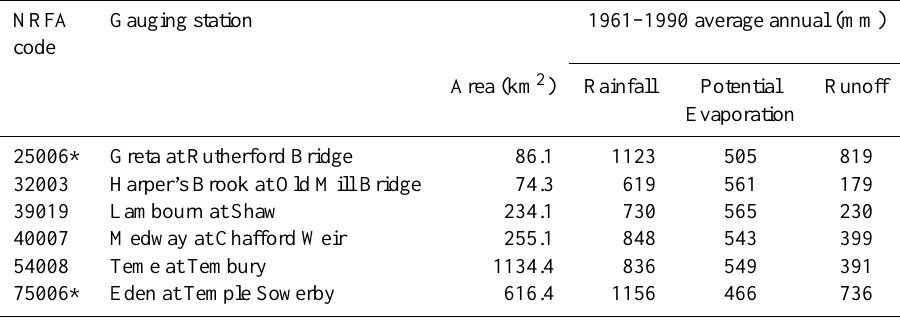
Table 1. Catchment